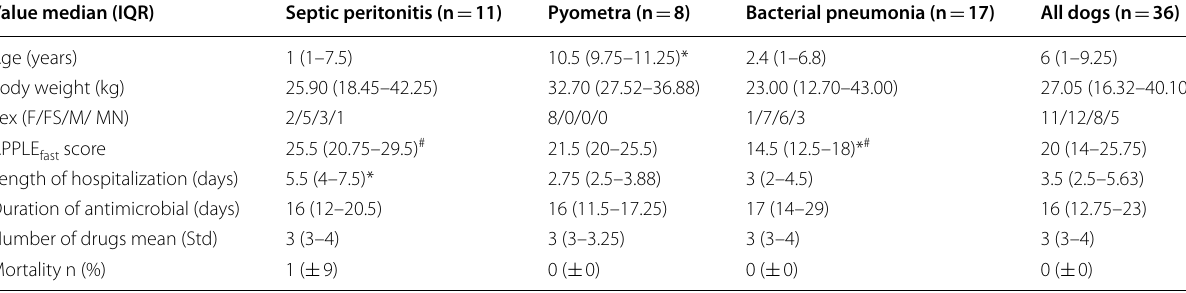
Table 1 Patient population description, with median and IQR